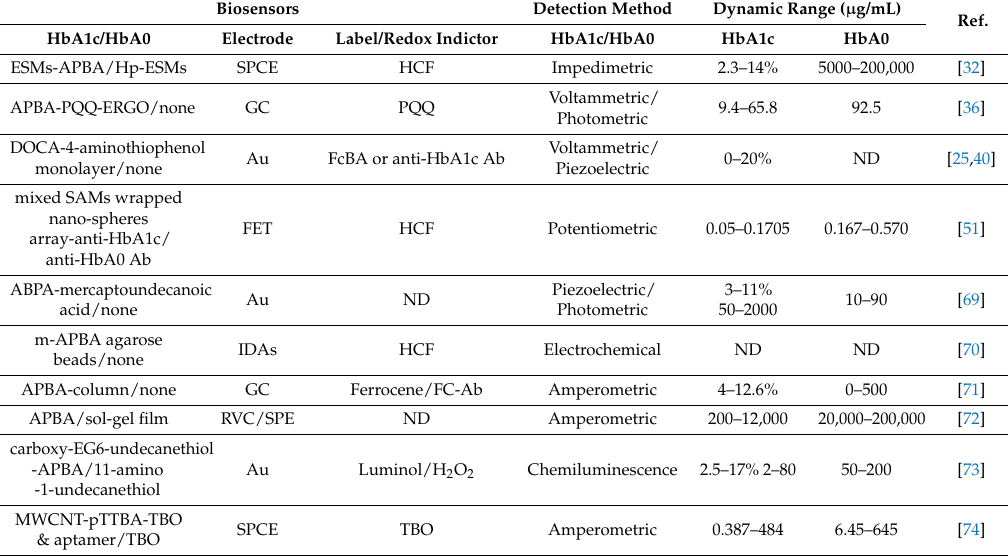
Table 5. HbA1c biosensors for whole blood sample